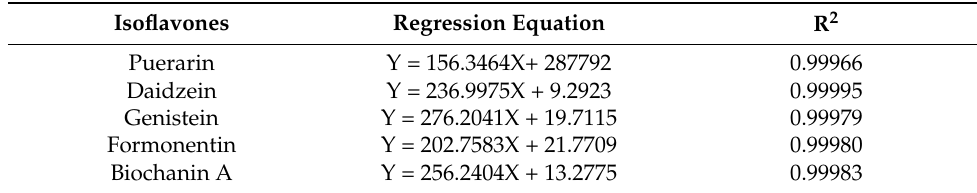
Table 1. Regression equation and R 2 of